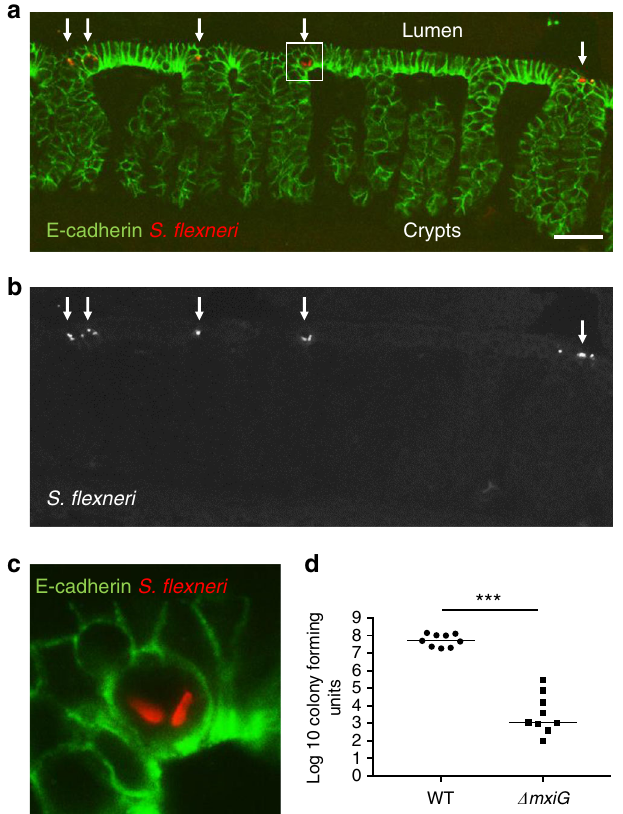
Fig. 3 Shigella fl exneri invades epithelia cells in a T3SS-dependent manner. a , b Representative images of colonic sections immuno-stained for E-cadherin and S. fl exneri . a Merge: E-cadherin, green; S. fl exneri , red. b S. fl exneri only. Arrows indicate intracellular S. fl exneri . Scale bars, 50 μ m. c Zoom-in on the boxed area in a . d Graph showing counts of colony- forming units in the distal colon of animals infected with S. fl exneri (wild-type (WT)) or the T3SS mutant ( Δ mxiG ). Statistical analysis, unpaired t test. Δ mxiG vs. WT, *** P < 0.0005. Source data are provided as